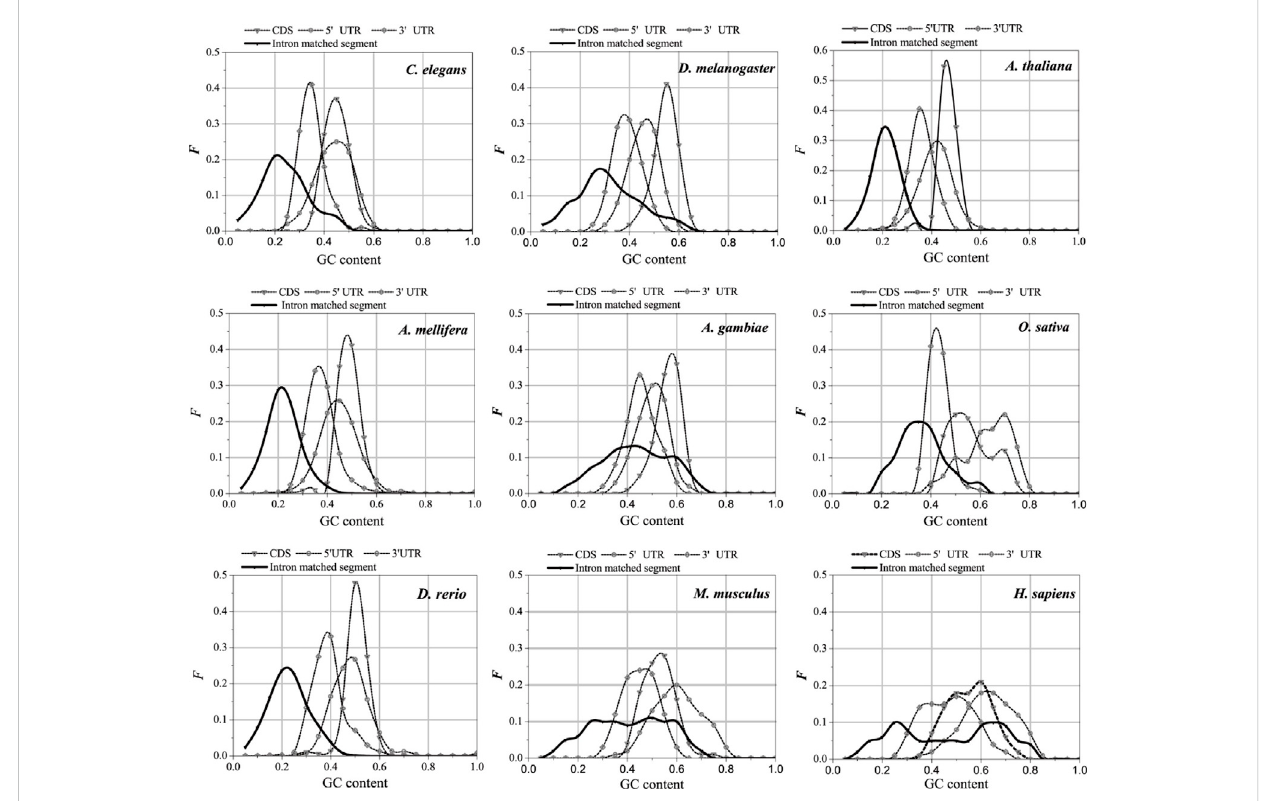
FIGURE 7 GC content distributions of different sequences. The X-axis is GC content and the Y-axis represents the Frequency values.